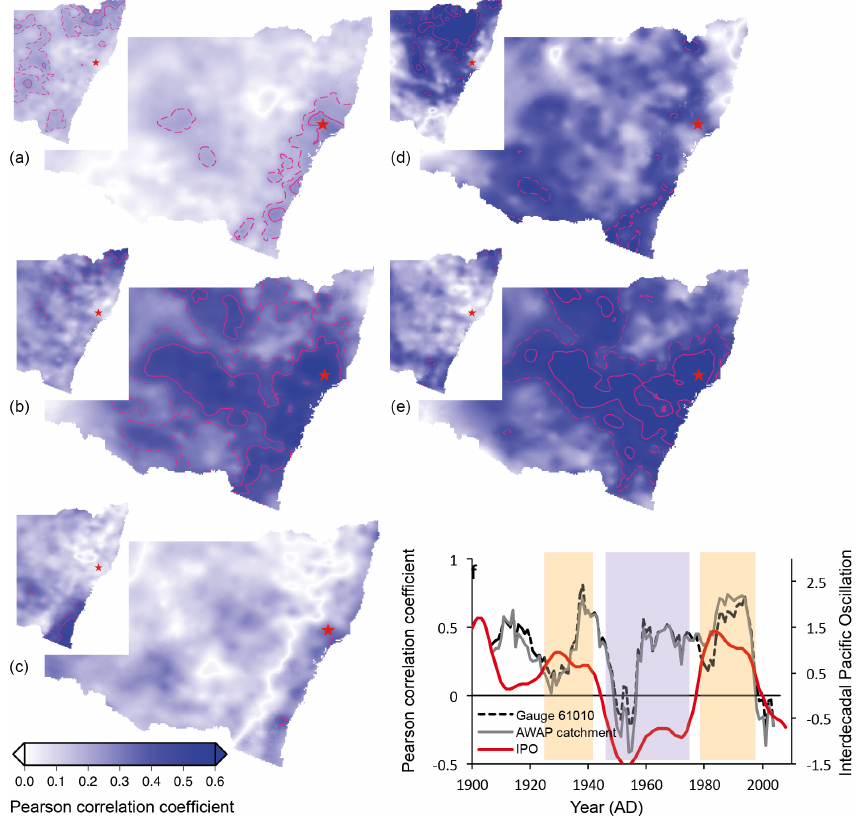
Figure 3. Correlations between (a) 12-month average (October–September) AWAP rainfall and LD SSS for the 1900–2010 period with inset showing correlations between annual AWAP rainfall calculated from January–December and LD SSS for 1900–2010 period, (b) as in (a) but for the combined IPO positive phases (1924–1941, 1979–1997), (c) as in (a) but for the IPO negative phase (1947–1975), (d) as in (a) but for the first IPO positive (1924–1941) phase (e) as in (a) but for the second IPO positive (1979–1997) phase and (f) 13- year moving window correlations between 12-month average (October–September) rainfall recorded at gauge 61010 and the AWAP WR catchment average and LD SSS with shading indicating IPO positive (yellow) and IPO negative (purple) phases (red line shown indicates 13-year smoothed instrumental IPO record). Note that for (a–e) the star represents the location of the WR catchment centroid, dashed pink line shows 99% significance